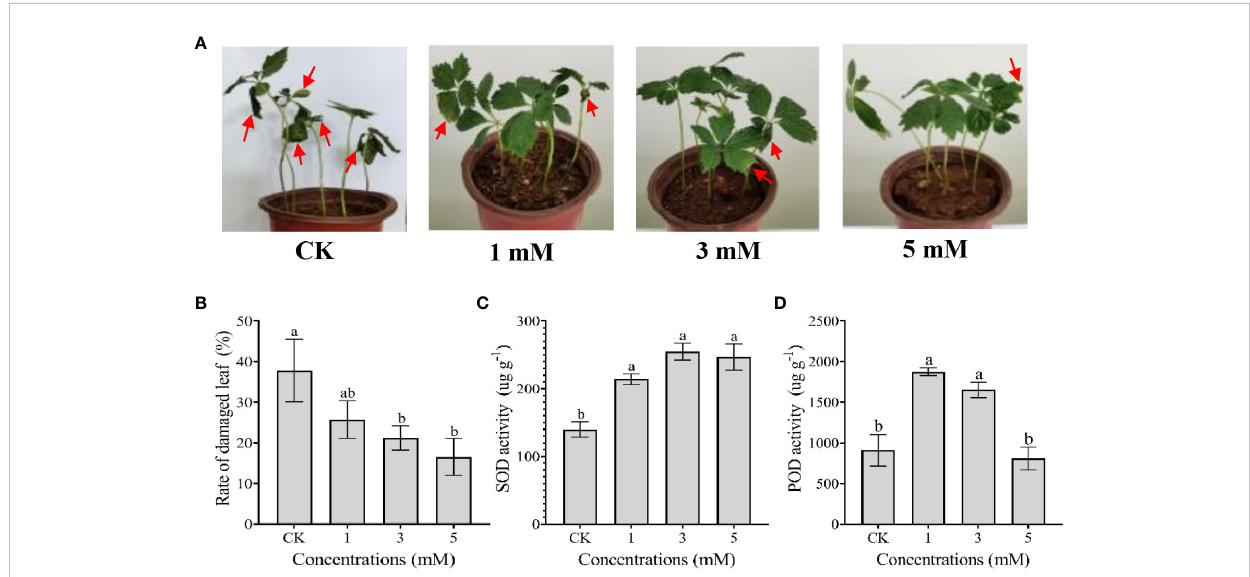
FIGURE 1 Effect of spraying leaves with exogenous leucine on the morphological and physiological responses of P. notoginseng under heat stress in the laboratory. (A) Morphology of P. notoginseng seedlings treated with sterilized deionized water (CK) and exogenous leucine at concentrations of 1, 3 and 5 mM once every two days while under heat stress for 15 days. (B) Changes in the damaged leaf rate of P. notoginseng treated with CK and leucine after 15 days of heat stress. (C, D) Changes in the activities of SOD and POD in P. notoginseng treated with CK and leucine after 15 days of heat stress, respectively. Error bars indicate the standard error (SE) calculated from six biological replicates. Different letters indicate statistically signi fi cant differences among the treatments by Duncan ’ s multiple range test at p <